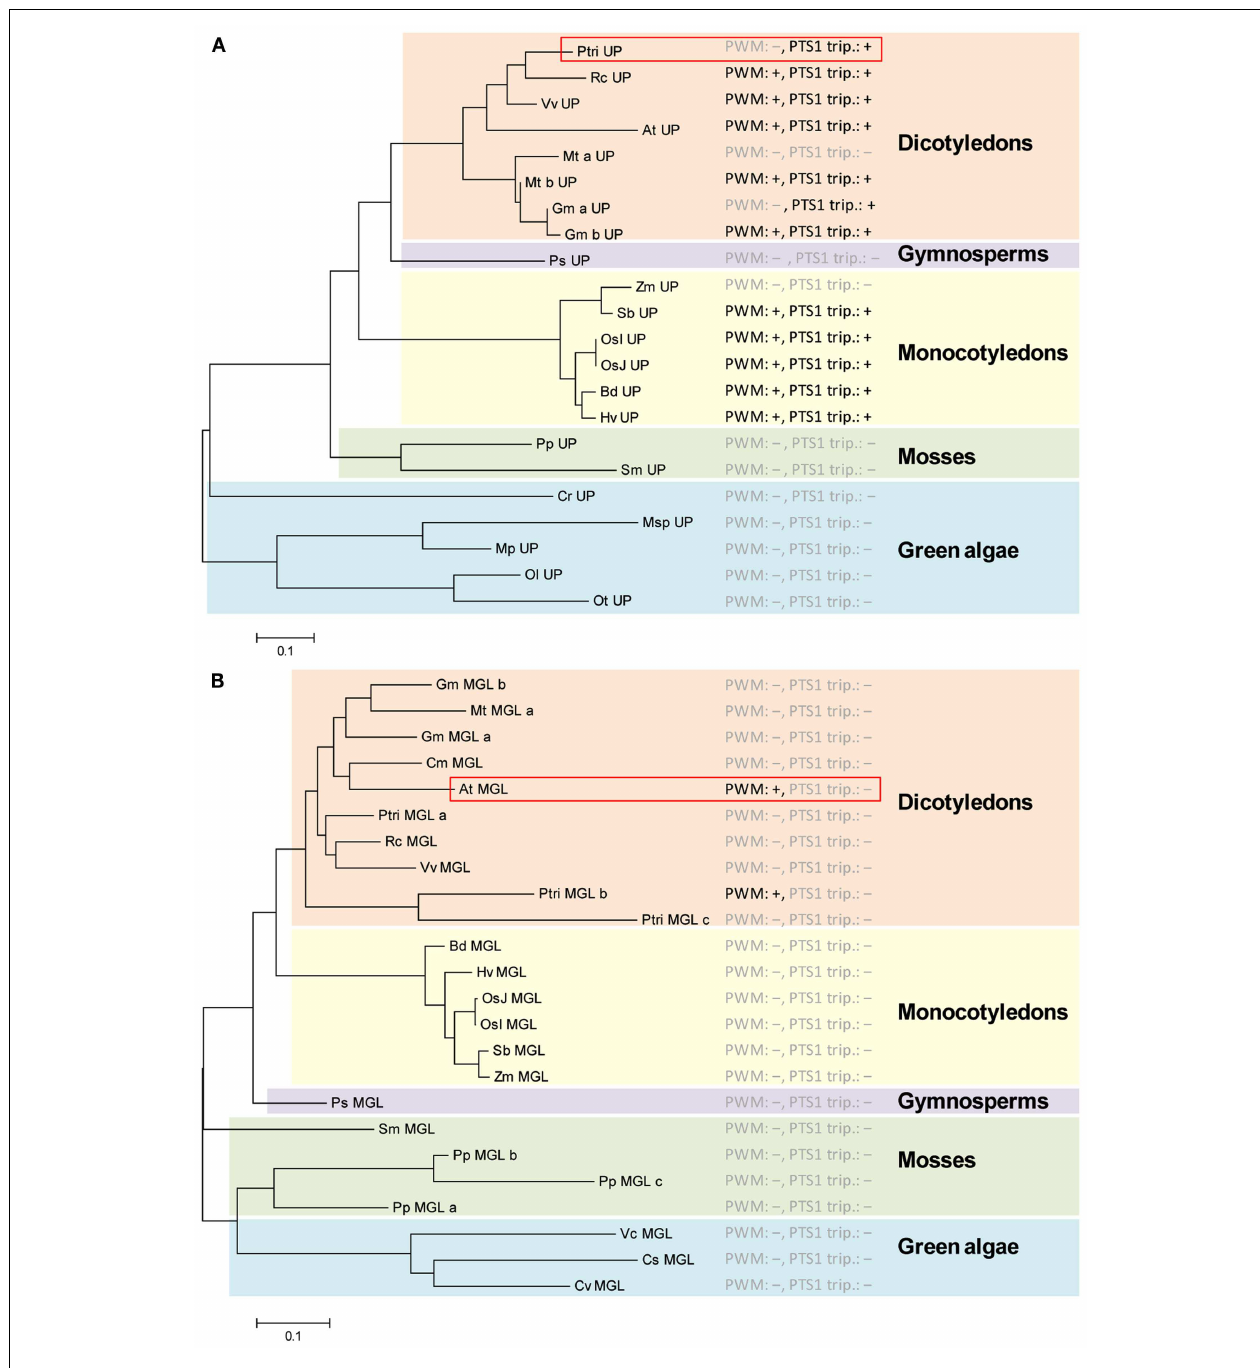
Bryophyta, Physcomitrella ), and in microalgae (chlorophyta, e.g., Micromonas , Ostreococcus ).The sequences were aligned using ClustalX, and the phylogenetic relationship among the sequences was analyzed by the neighbor joining method using MEGA 5. For all putative orthologs the PWM-based PTS1 protein prediction scores and the presence of experimentally validated PTS1 tripeptides were determined ( TablesA2 and A3 in Appendix). Positive ( + ) and negative ( − ) PWM-based PTS1 protein predictions (e.g., PWM: + ) and experimentally validated PTS1 tripeptides (PTS1 trip.: + ) are indicated. For At UP (At4g33925) the predictions are given only for the first splice